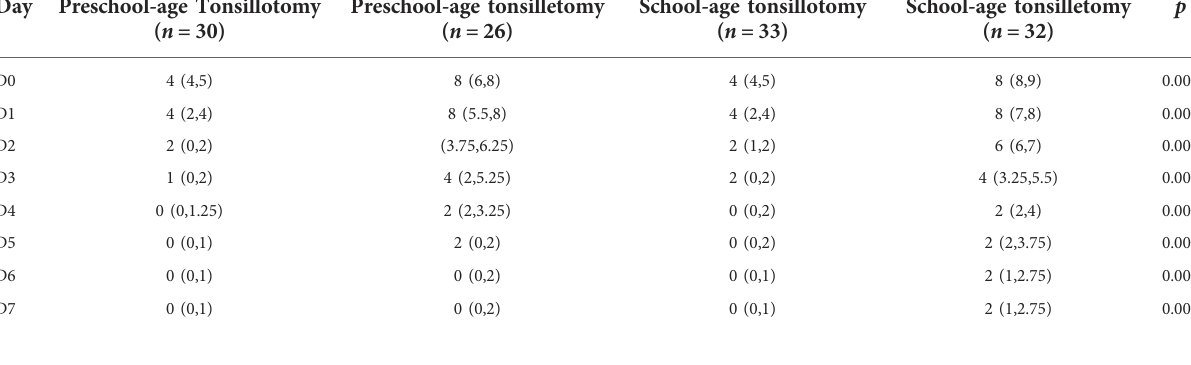
TABLE 4 Comparisons of pharyngeal pain (PPPM scores) in preschool and school-age children between the tonsillotomy and tonsillectomy groups. Day Preschool-age Tonsillotomy ( n =